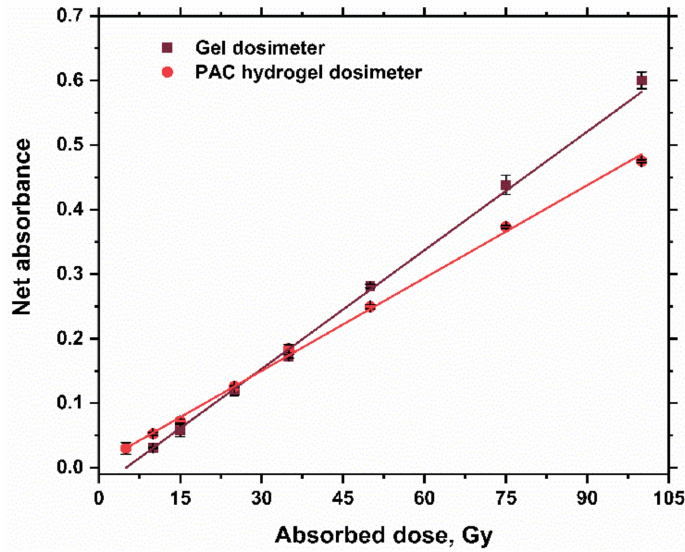
Figure 12. Response curves of gel dosimeter (100 mM Ag + ions) at 450 nm [36] and PAC hydrogel dosimeter (100 mM Ag + ions) at 453